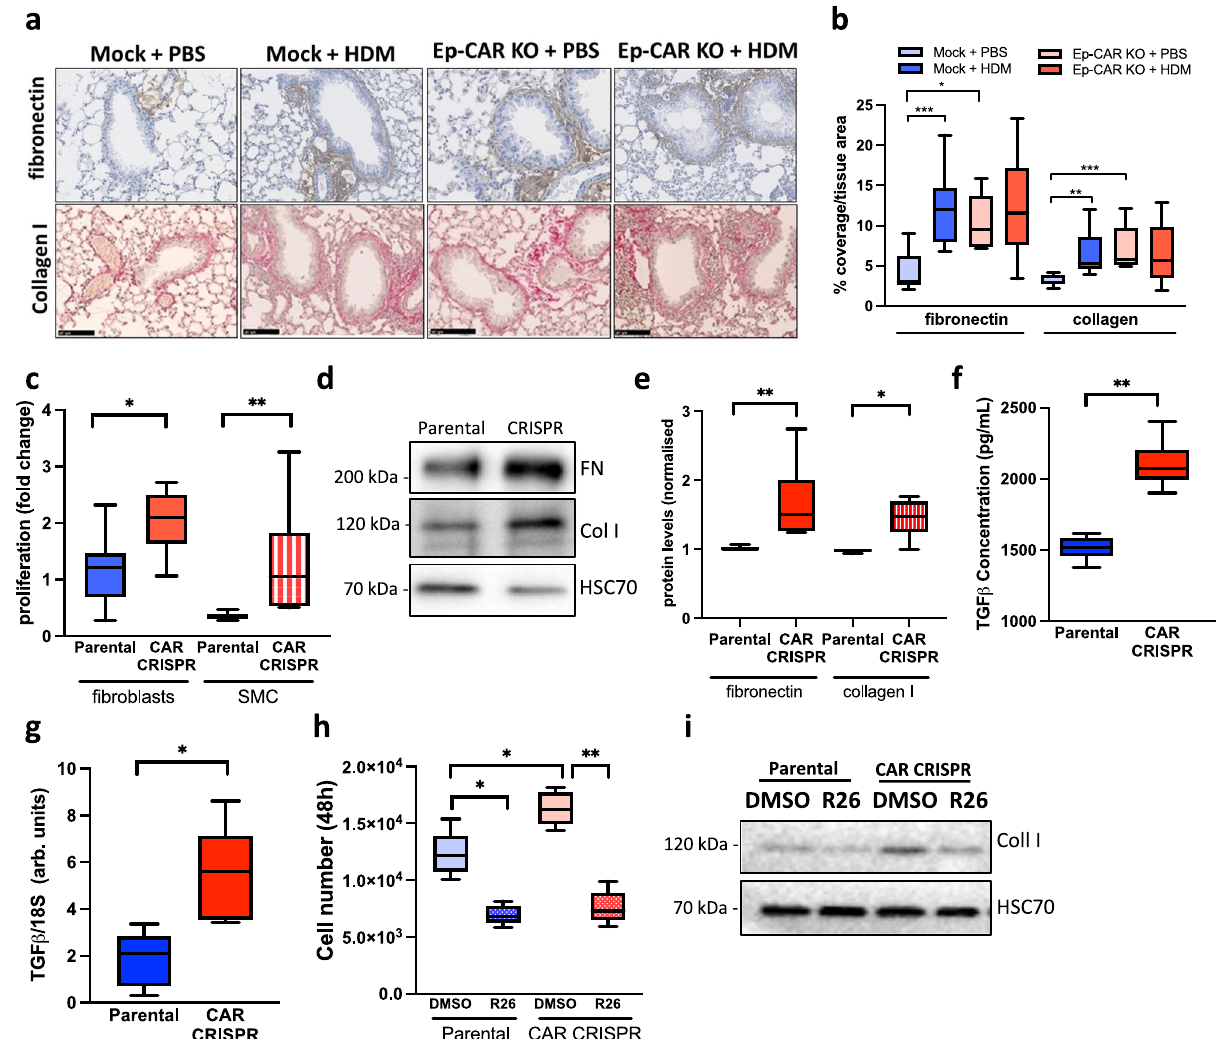
Fig. 7 | Epithelial depletion of CAR induces TGF- β -dependent airway remodel- ling. a Representative images of sections of lungs from mice under speci fi ed conditions stained for fi bronectin (antibody; brown) and collagen (Sirius red; pink) staining. Scale bar: 100mm. b Quanti fi cation of fi bronectin and collagen staining around the airways from 20 airways in FFPE lung sections from each experimental group; from 5 mice per condition (one lung per mouse) repre- sentative of 3 independent experiments. c Quanti fi cation of proliferation of primary human lung fi broblasts and airway smooth muscle cells (SMC) treated with supernatants from 16HBE parental or CAR CRISPR cells for 48h. Data. d Lysates from primary human lung fi broblasts treated as in c and probed for data as in d . f TGF- β levels measured by ELISA in supernatants from 16HBE parental and CAR CRISPR cells. 3 replicates per condition, pooled from